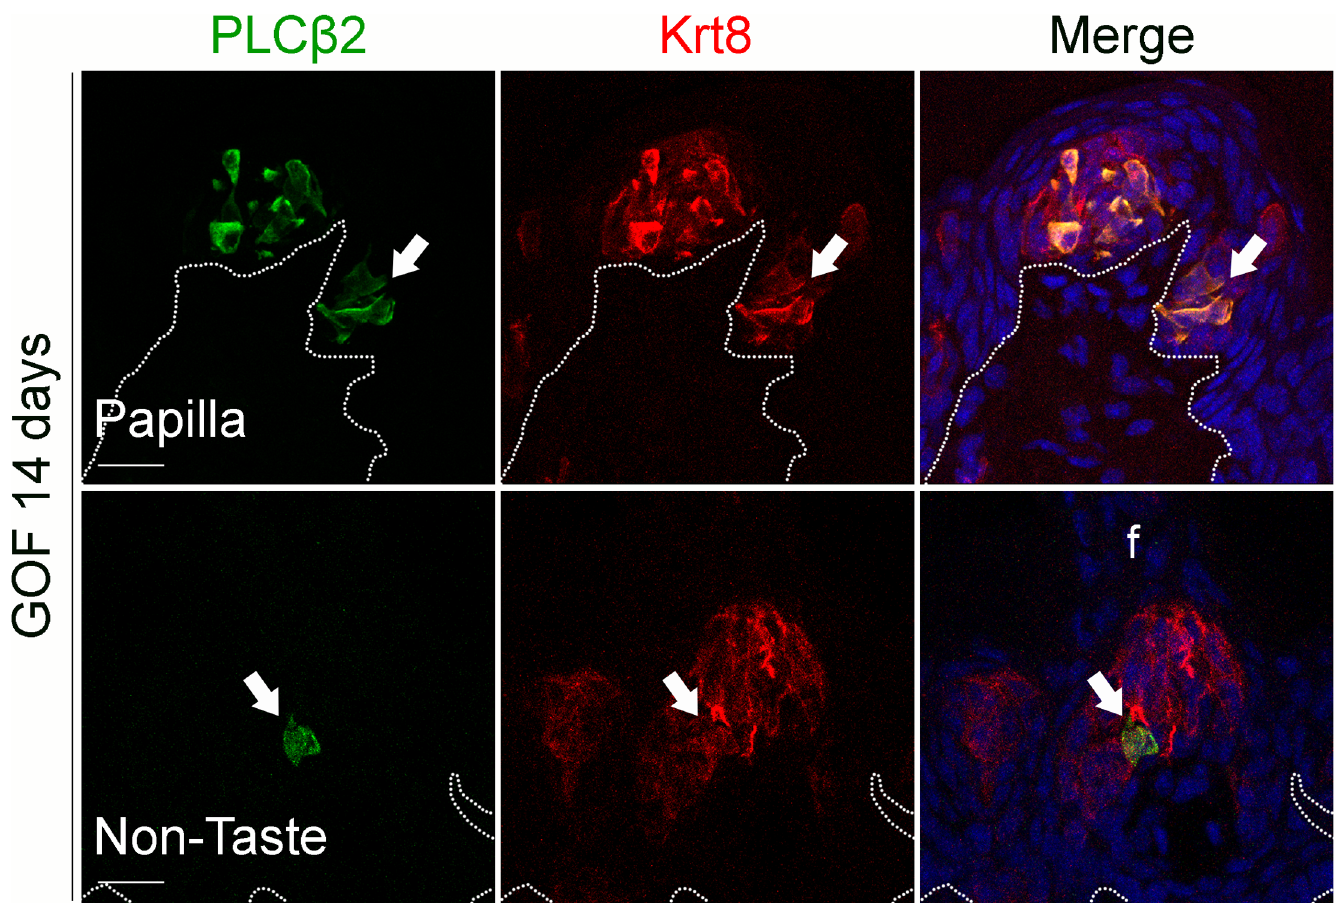
Fig 5. Prolonged stabilization of β -catenin in Krt5 + progenitors induces differentiation of a small number of Type II cells in ectopic taste bud-like structures in the anterior tongue. After induction with dox chow for 14 days, 5.8 ± 2% of anterior Krt8 + ectopic structures (total of 485 Krt8 + structures counted, 23 with PLC β 2, n = 3 mice) expressed PLC β 2 (green, white arrows). These ectopic structures never expressed the Type III cell marker SNAP25 (total of 356 Krt8 + structures counted, 0 with SNAP25 + cells, n = 3 mice). Nuclei were counterstained with DRAQ5 in blue. Representative stack images from 3 mutant mice. Dotted line delineates the basement membrane. Scale bars = 20 μ